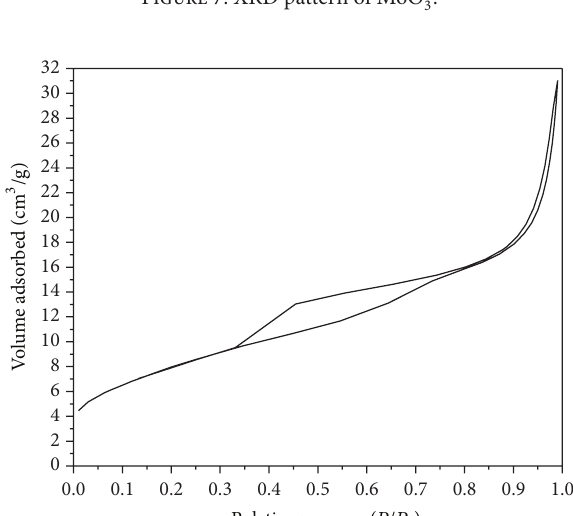
Figure 7: XRD pattern of MoO 3 .